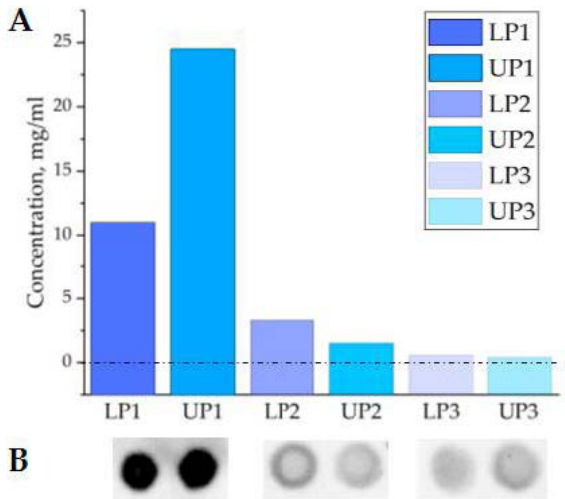
Figure 7. Protein concentration in two phases of PTPS during consequent separation. ( A ) Total protein concentration measured by Bradford assay. ( B ) Albumin quantity assayed by dot